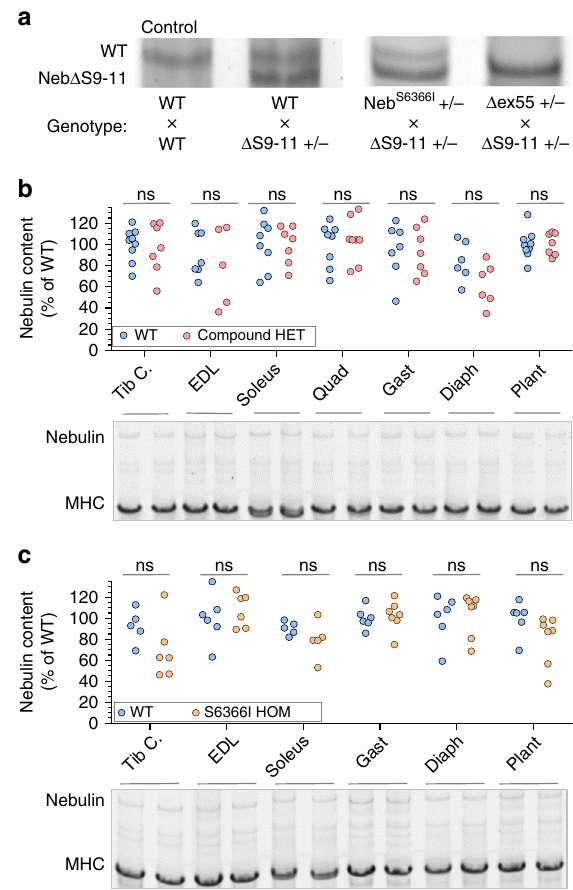
Fig. 3 Nebulin protein expression. a Nebulin isoform expression was assessed in muscles from mice with one Neb Δ S9-11 -allele (this expresses a nebulin lacking super-repeats 9-11, generating a smaller than wild type nebulin) and the other allele either WT, Neb S6366I or Neb Δ ex55 . The latter two alleles are expected to produce a nebulin protein of wildtype size (assuming they express protein, see text for details). Top: protein gels with nebulin protein bands; bottom: genotype of mouse from which muscle was obtained (gastrocnemius muscle). The left lane is from a WT mouse revealing WT nebulin and the second lane is from a heterozygous Neb Δ S9-11 mouse that reveals WT nebulin (top band) and a bottom nebulin band produced by the Neb Δ S9-11 allele. Lanes 3 and 4 show that the Neb S6366I allele produces full-length nebulin but that the Neb Δ ex55 does not. Identical results (not shown) were obtained in other examined muscle types (EDL, soleus Tibialis C. gastrocnemius and diaphragm), two mice per genotype with 6 muscle types studied per mouse. See text for details. b , c Expression levels of nebulin relative to myosin heavy chain (MHC) in a range of muscle types. Analyzed results (top) and gel examples (bottom) of a Compound- HET mice (Neb S6366I/ Δ exon55 ), and b The Neb S6366I homozygous mice. No differences in nebulin protein levels were found in any of the studied muscle types. 2-Way ANOVA with multiple comparison (multiple comparison correction (Sidak)). ns not signi fi cant. Number of mice in b : WT: 9, Compound-Het: 8. Number of mice in c : WT: 6, and S6366I Hom: 7. Source data are provided as a Source Data fi